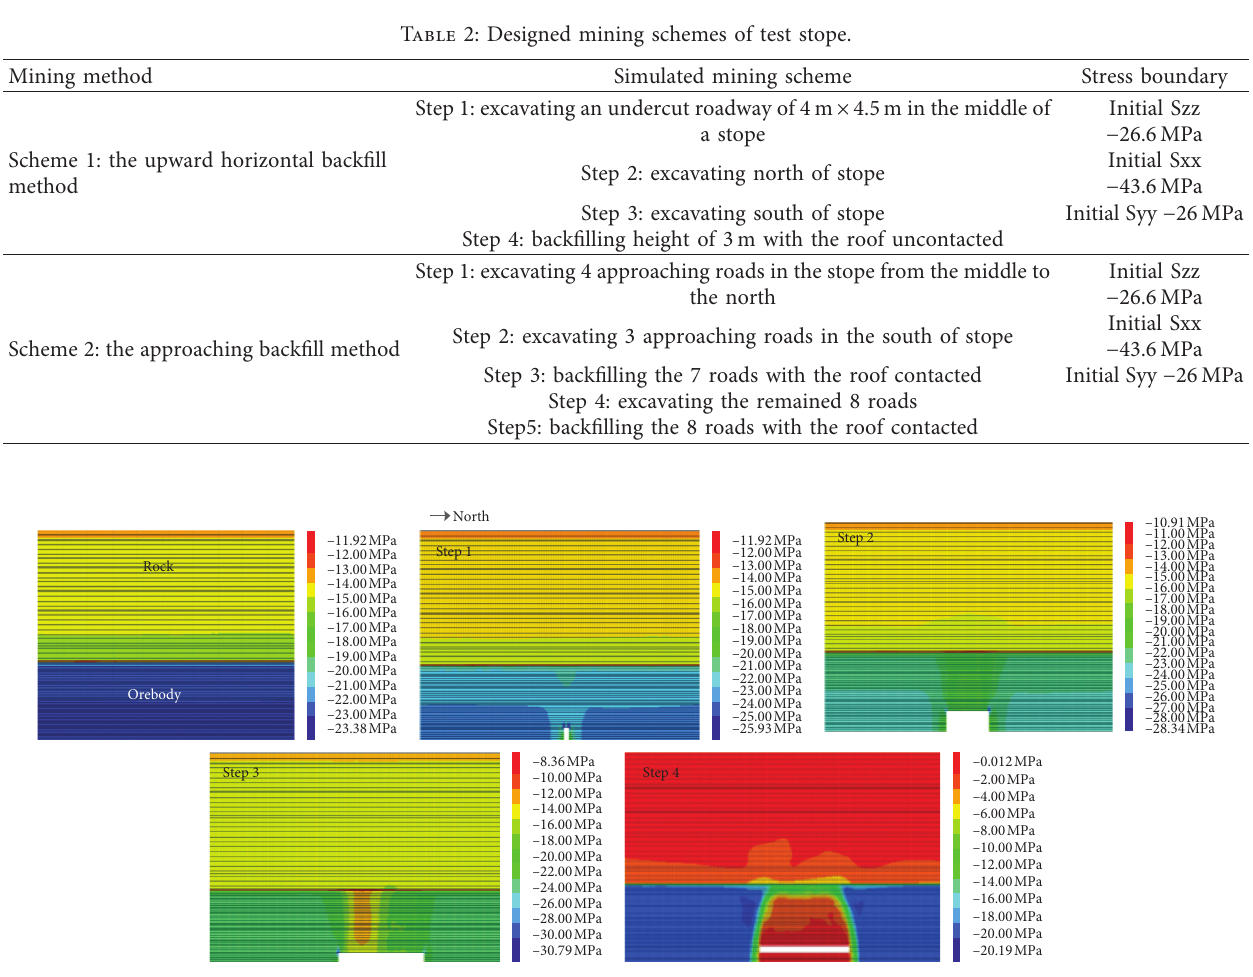
Figure 8: Stress transferring process of Scheme 1 (contour of maximum principal stress, X �